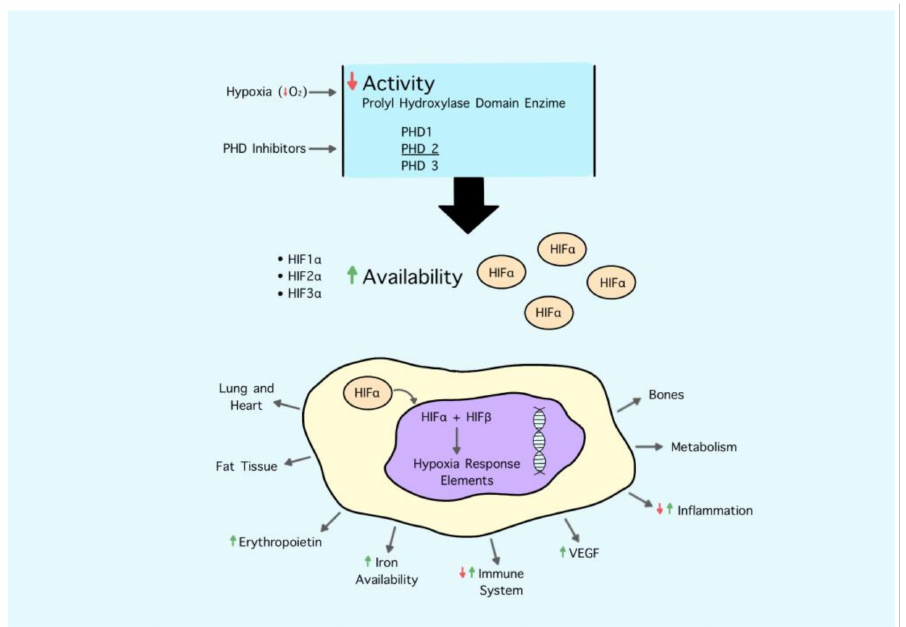
Figure 1. Hypoxia inducible factor (HIF) is a heterodimer composed of oxygen-sensitive HIF α and constitutively expressed HIF- β subunits. Under normal conditions, the HIF- α subunit is rapidly degraded by prolyl hydroxylation domain protein (PHD). During hypoxia or following treatment with PHD inhibitors, PHD is less active and thus more HIF- α is available to translocate into the nucleus. Here it recruits HIF-1 β and induces the expression of specific target genes, including those leading to the synthesis of erythropoietin and controlling iron